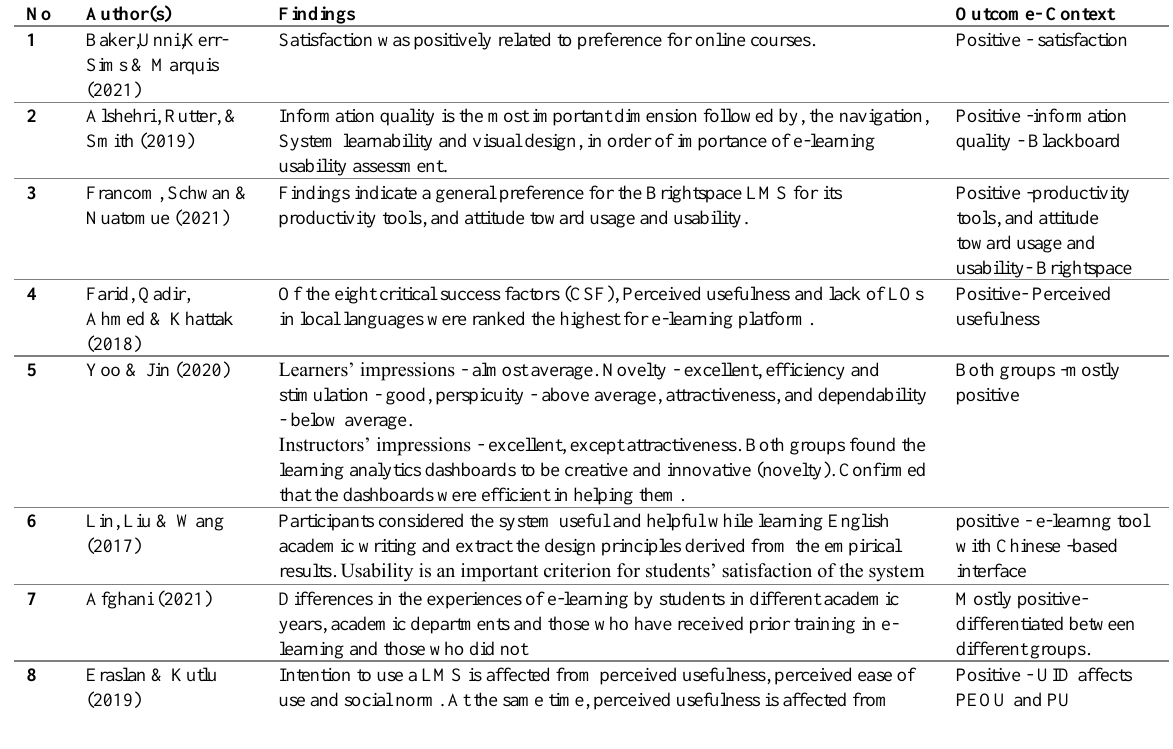
Table 3: Summary of the outcome of the